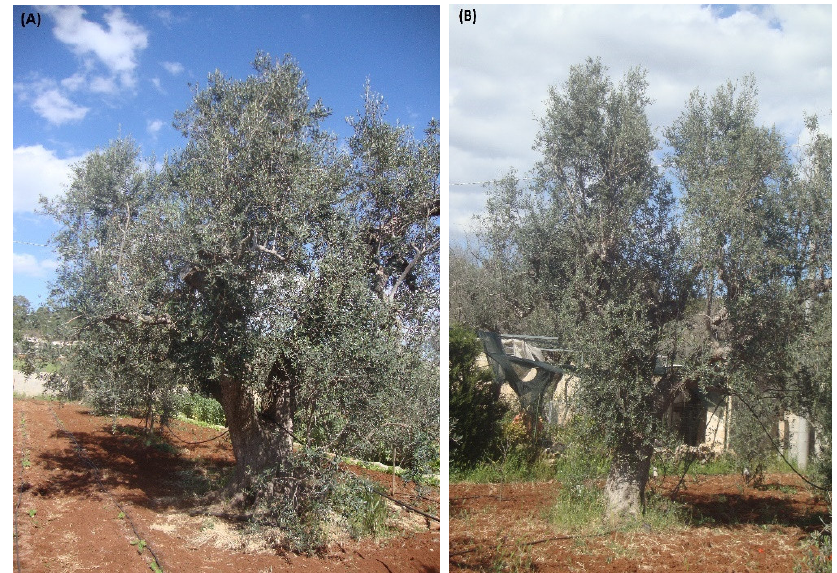
Figure 13. Resilient centennial olive trees in Gallipoli area where OQDS was first observed. Both Cellina di Nardò ( A ) and Ogliarola salentina ( B ) trees do not show any apparent symptom even though both trees resulted positive for the occurrence of Xylella fastidiosa subsp. pauca. These trees did not receive any treatment upon the infection and began to yield fruits.